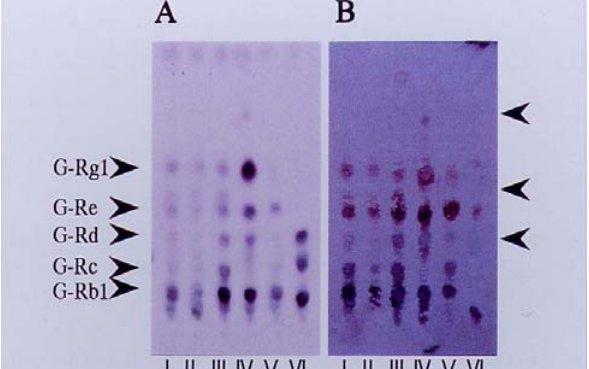
A: TLC profile stained by sulfuric acid. B: Eastern blotting by anti-ginsenoside-Rb1